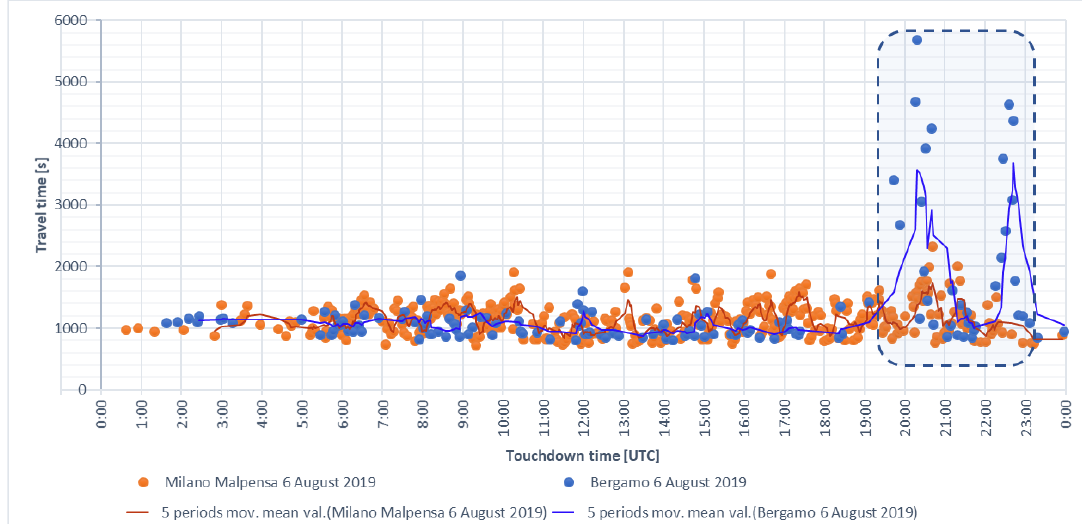
Figure 10. Travel time in the extended TMA vs. touchdown time for historical traffic at MXP (orange color) and at BGY (blue color) on 6 August 2019.